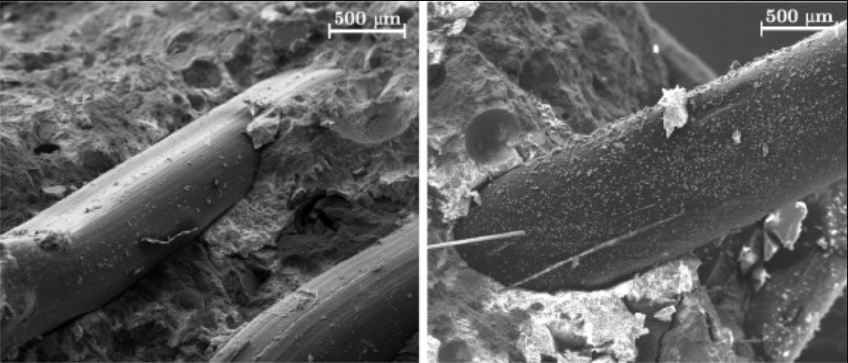
Figure 12. The surface of samples after bending test: non-modified PP fibres ( left ) and silica-coated PP fibres ( right ) [130].